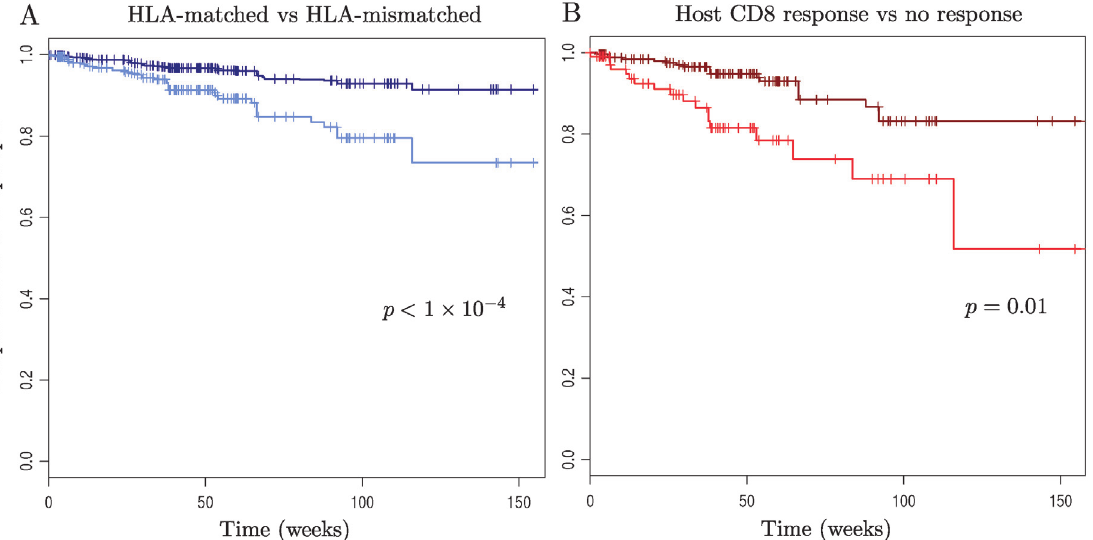
Figure 4. Kaplan-Meier survival curves for wild-type epitopes. For the 114 patients and 46 epitopes for which appropriate sequence data was available: (A) Time to escape in epitopes within HLA-mismatched (dark blue) and-matched (light blue) hosts is shown. (B) Epitopes in HLA-matched hosts are split according to whether they have a measurable CD8 + T-cell ELISpot response to them (light red) or not (dark red). Escape is strongly significantly faster in epitopes within HLA-matched hosts (p < 1×10 -4 ), hazard ratio = 2.6, 95% C.I. = (1.7, 4.2)) and then faster again if the host has a measurable CD8 + T-cell ELISpot response to that epitope (p = 0.013, hazard ratio = 3.0, 95% C.I = (1.3, 7.0)). Note that p-values and hazard ratios were calculated using a mixed effects model with random intercept terms for both patient and epitope ID, to account for correlation of observations within patients and within epitopes (see